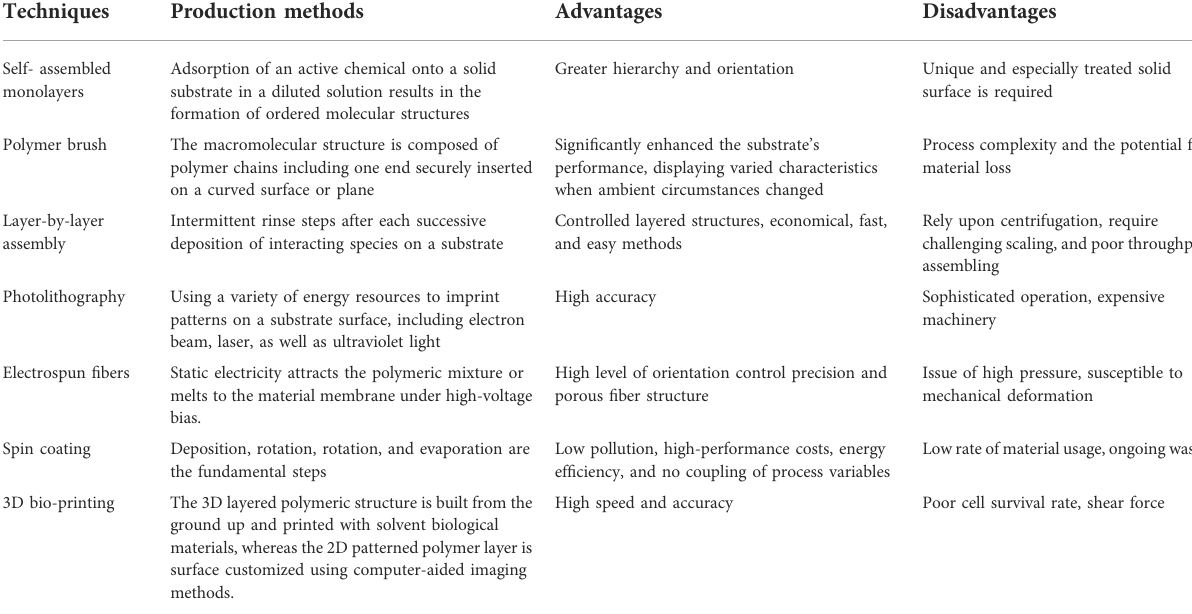
TABLE 4 Different strategies for developing cell adhesion